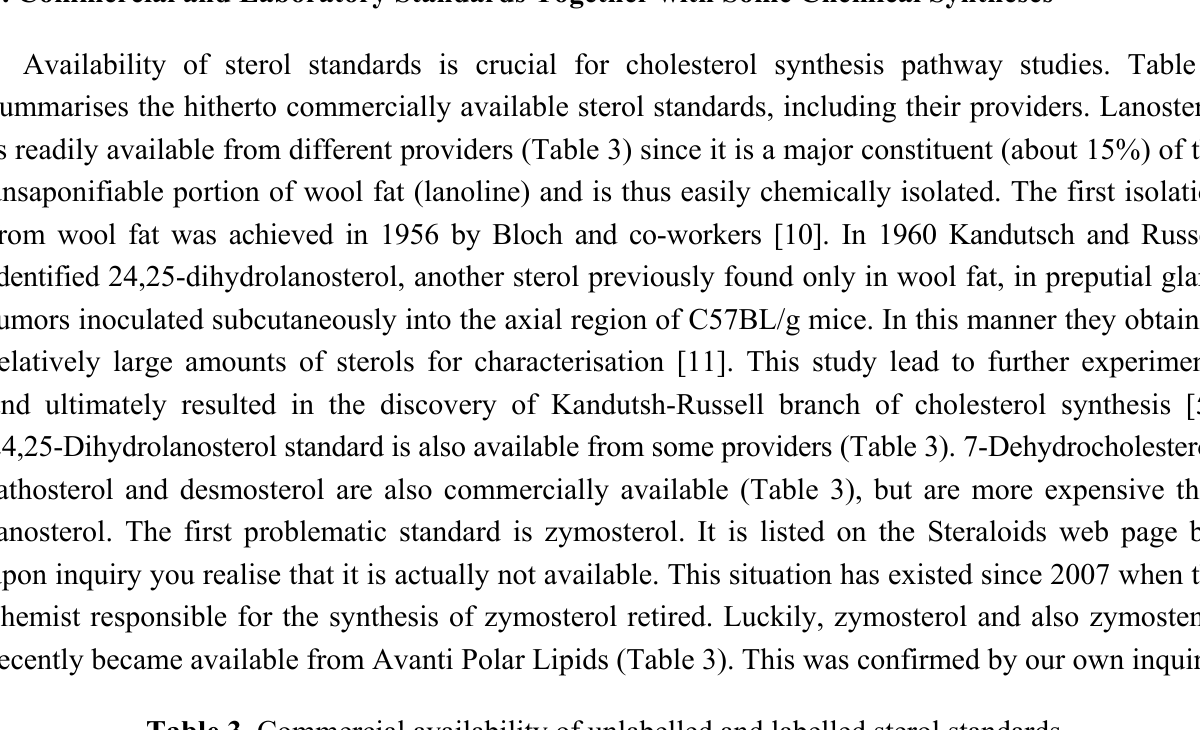
Table 3. Commercial availability of unlabelled and labelled sterol